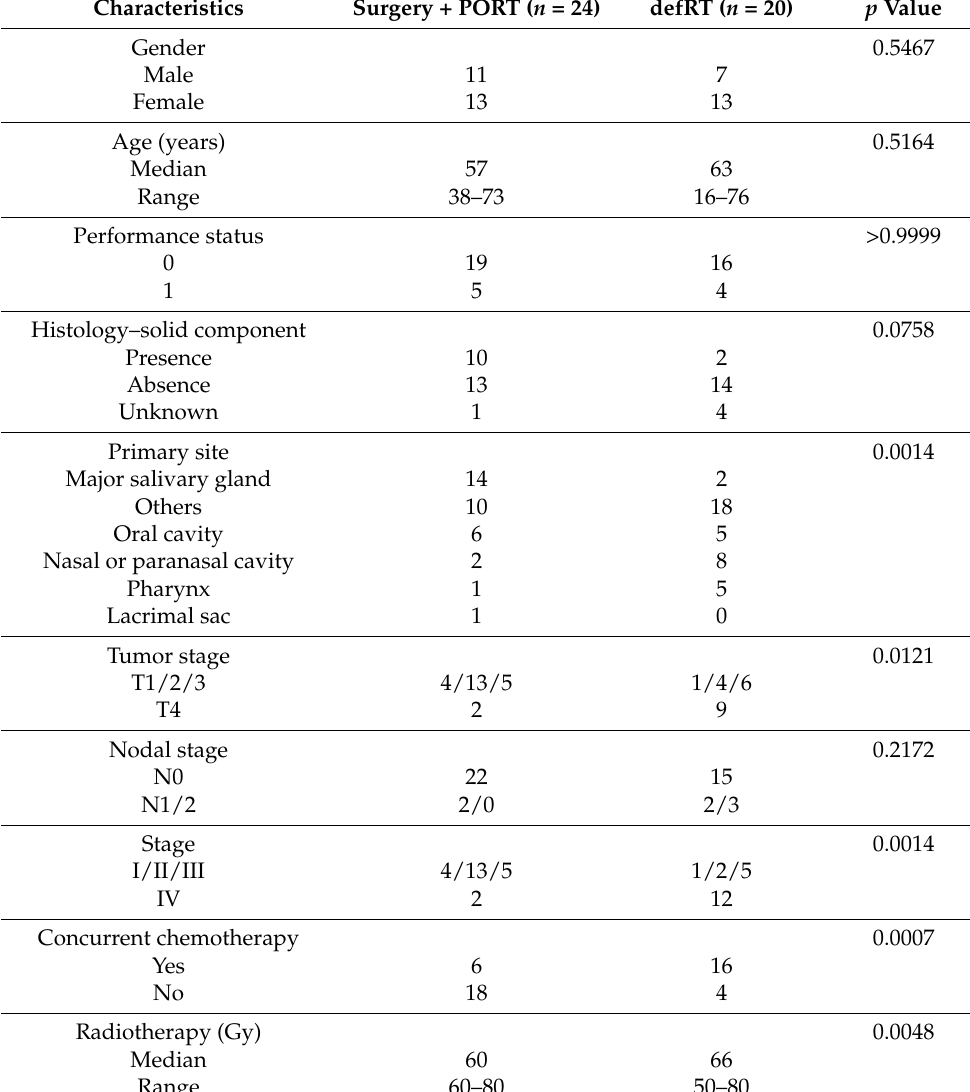
Table 1. Characteristics of the